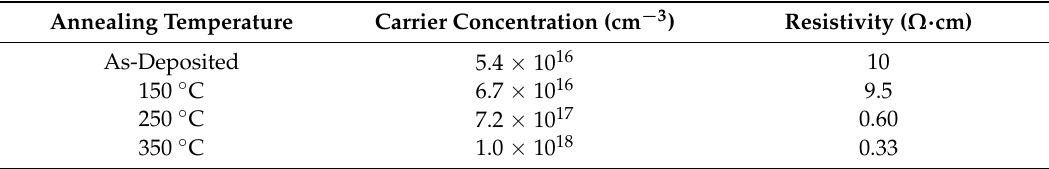
Table 2. Electrical property data of the IZTO thin films deposited by RF magnetron sputtering on glass substrates at various annealing temperatures in the range of 150–350 °C.